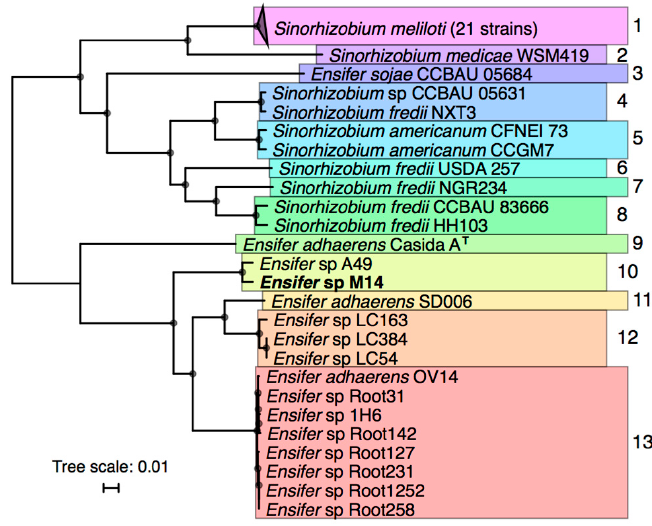
Figure 2. Phylogeny of a selected 46 Sinorhizobium / Ensifer strains with a publicly available whole genome sequence. An unrooted RAxML maximum likelihood phylogeny of 46 Sinorhizobium / Ensifer